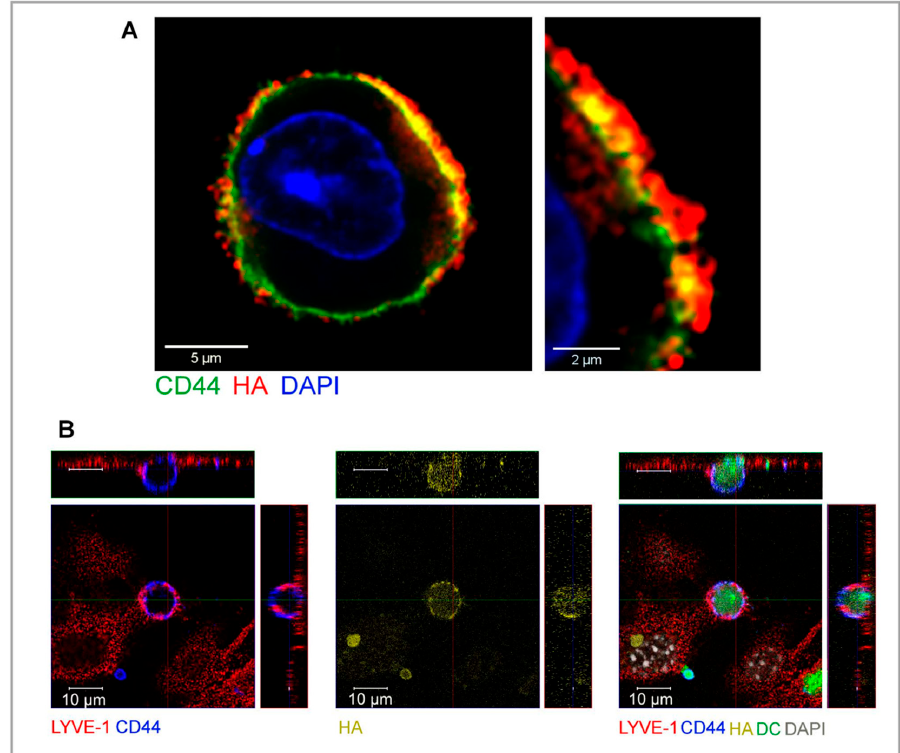
Figure 3. The HA glycocalyx on the surface of DCs and its involvement in docking to lymphatic endothelium via LYVE-1 transmigratory cups. Panel ( A ) shows the HA glycocalyx on the surface of an LPS-matured mouse bmDC, detected with bVG1/streptavidin-AF647, dual stained for CD44/AF488 and counterstained for nuclei with DAPI, imaged by confocal microscopy with Airyscan detection and digital zoom (right). Panel ( B ) illustrates the docking of a mouse bmDC to the surface of a LEC through formation of a LYVE-1 transmigratory cup that encircles the cell and engages with the HA glycocalyx. Shown are confocal microscopy images with orthogonal views of mouse LEC monolayers immunostained with anti-LYVE-1/AF548 (red), recorded 3 h after the addition of LPS-matured fluorescent bmDCs (green) dual immunostained for anti-CD44/AF594 (blue), and bVG1/streptavidin-AF647 (yellow), and counterstained for nuclei with DAPI (grey). Adapted from Johnson et al. 2021 [114] under Creative Commons BY